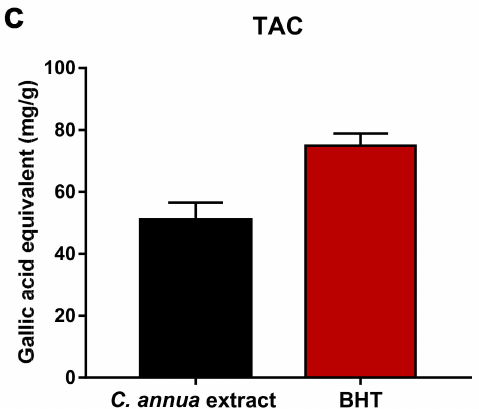
Figure 3. Antioxidant activity of C. annua crude extract ( a ) The IC 50 value of 2,2-diphenyl- 1-picrylhydrazyl (DPPH) radical scavenging assay, ( b ) ferric-ion reducing antioxidant power (FRAP) assay and ( c ) total antioxidant capacity (TAC)